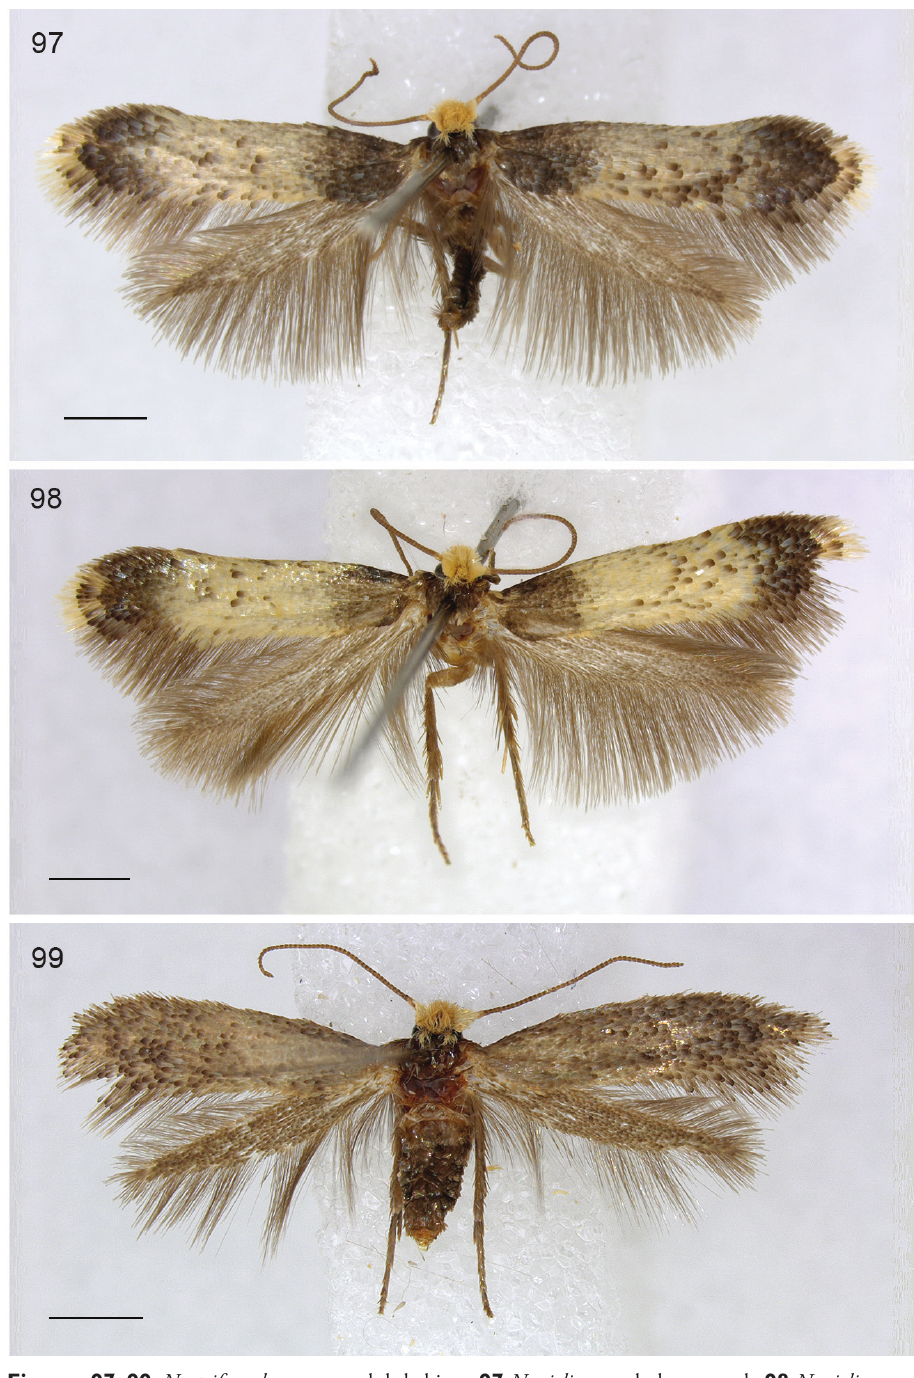
Figures 97–99. Neotrifurcula gen. n., adult habitus. 97 N. gielisorum , holotype male 98 N. gielisorum , male, RMNH.INS.23627 99 N. specimen EvN4504, female, RMNH.INS.24504. Scale bars: 1